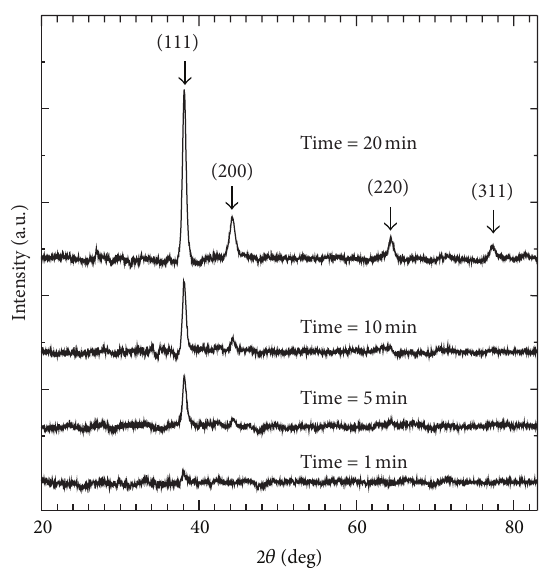
Figure 2: XRD patterns of Ag NPs film at various deposition times of 1, 5, 10, and